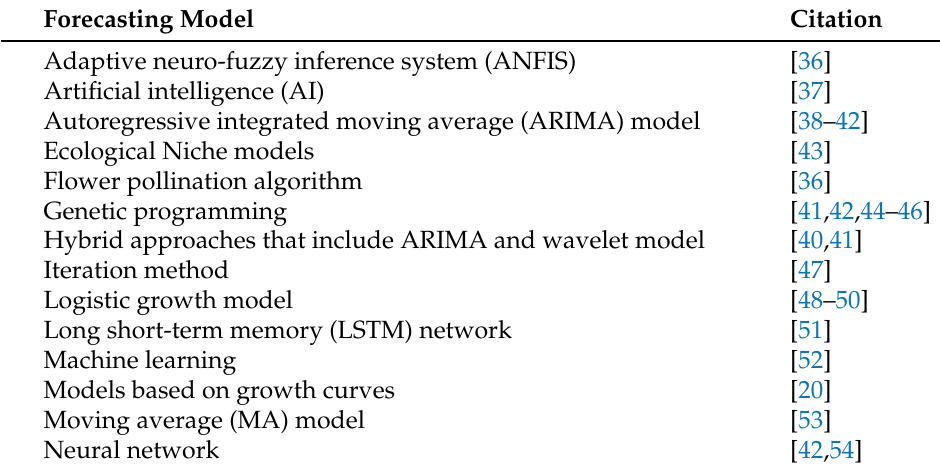
Table A1. COVID-19 forecasting models from the